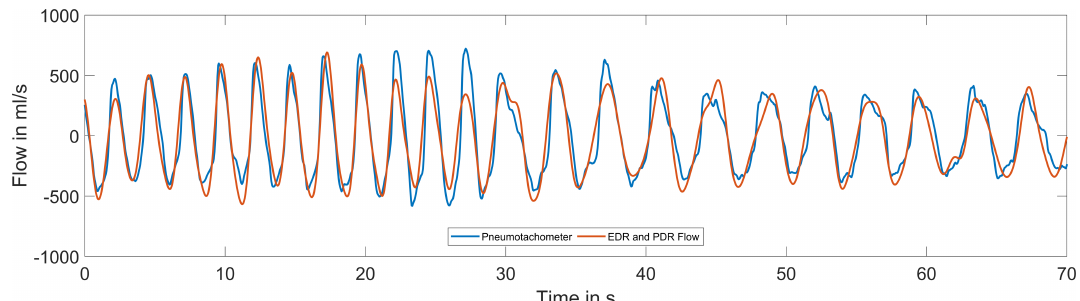
Figure 14. Example reference and estimated respiratory signal using ECG- and PCG-derived